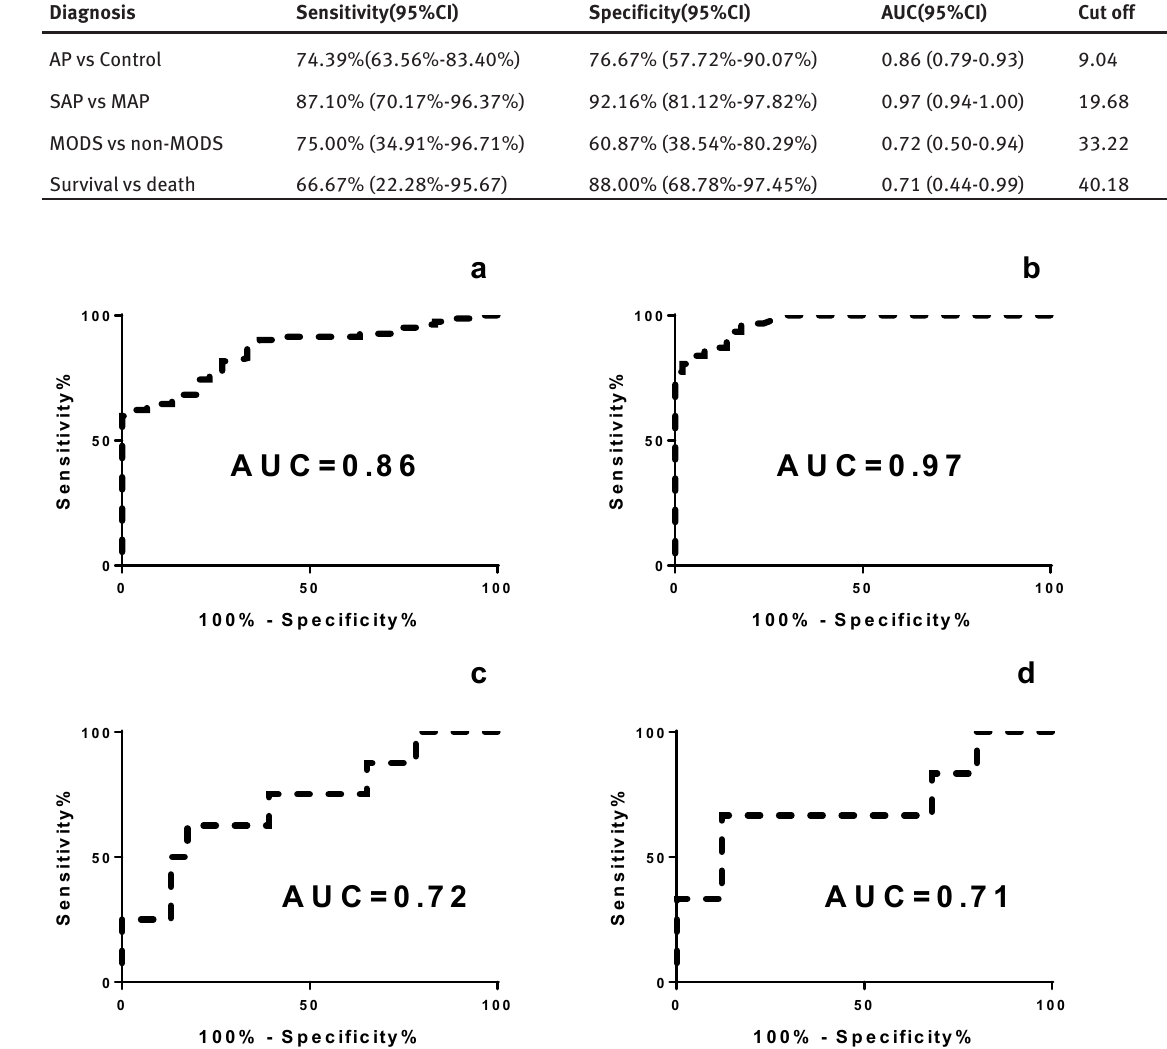
Figure 2: Receiver operating characteristic (ROC) curves of serum neopterin as biomarker for AP diagnosis and mortality risk (a)ROC curve for AP diagnosis; b) ROC curve for AP severity differential diagnosis; c) ROC curve for MODS diagnosis; d) ROC curve for mortality